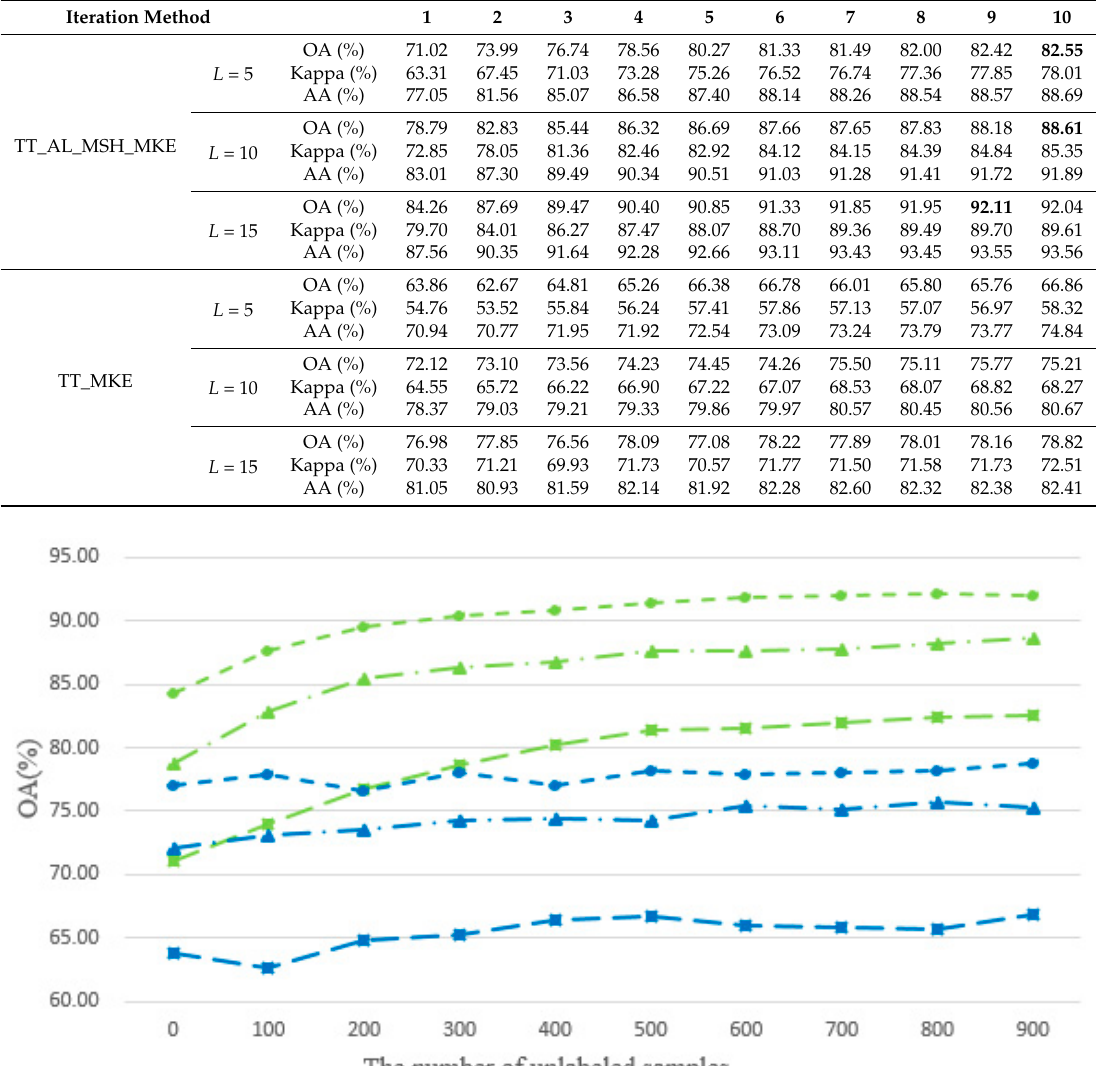
Table 6. Overall accuracy using two different techniques for ROSIS Pavia University data, with 5, 10 and 15 initial training samples per class. The best OA results of each table are marked in bold italics.